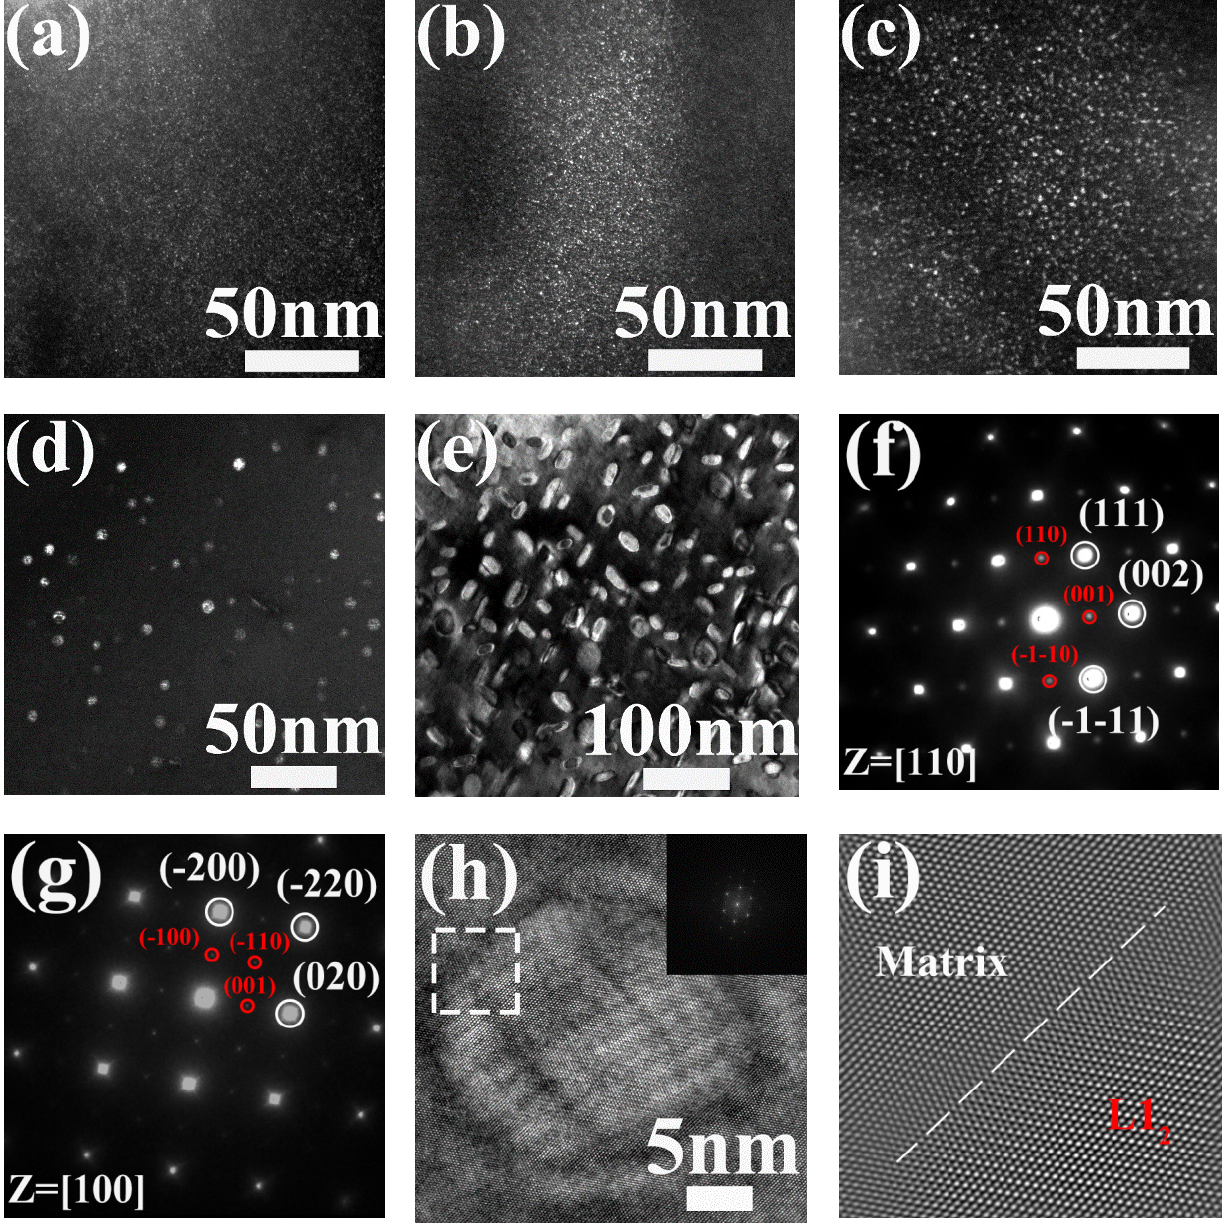
Figure 2. TEM images and corresponding SADP of L1 2 phase in annealed as-castAl 0.3 CoCrFeNi high-entropy alloy: ( a ) AH500 sample; ( b ) AH540 sample; ( c ) AH590 sample; ( d ) AH660 sample; ( e ) AH700 sample; ( f ) SADP of AH590 sample; ( g ) SADP of AH700 sample; ( h , i ) high-resolution scanning TEM images of L1 2 in AH700.